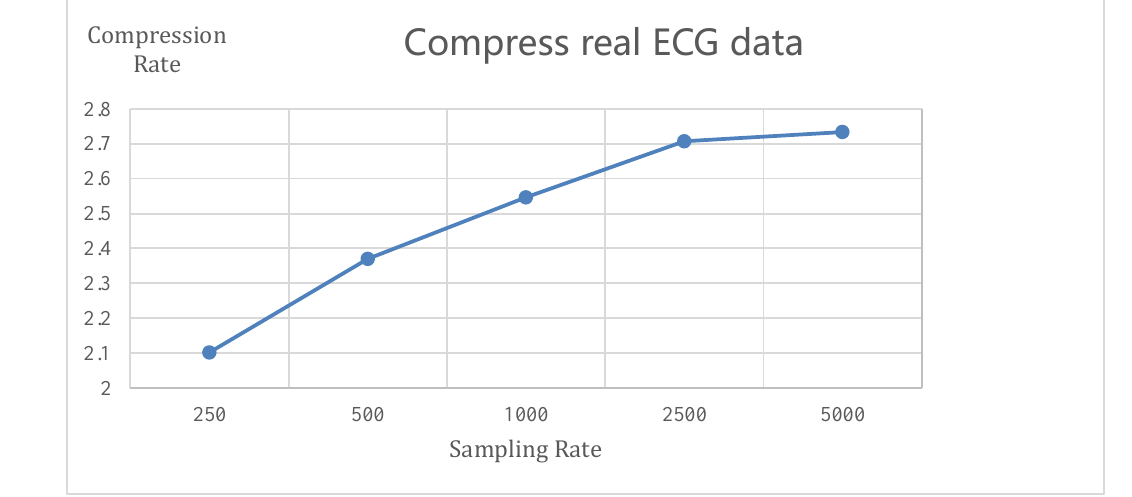
Figure 14. FPGA compresses real ECG data.